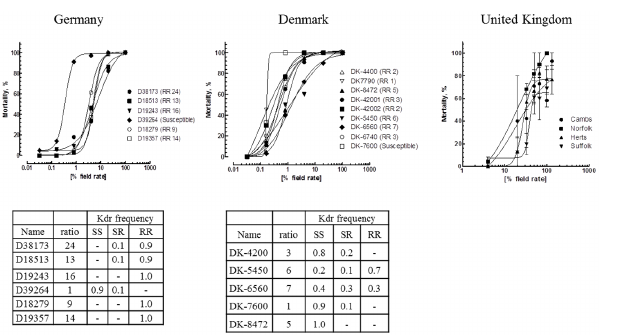
Fig 2. Dose-response curves and frequency of the kdr mutation for each of the three countries of this study. It was not possible to calculate resistance ratios (RR) for the UK samples, as they are much less sensitive. Six representative samples were analyzed from Germany, five from Denmark and four from the UK.